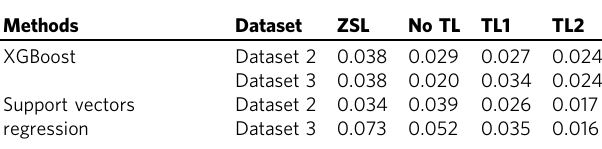
Table 3 Test RMSEs of battery capacity estimation using zero-shot learning (ZSL) and different transfer learning (TL) methods on dataset 2 and dataset 3.